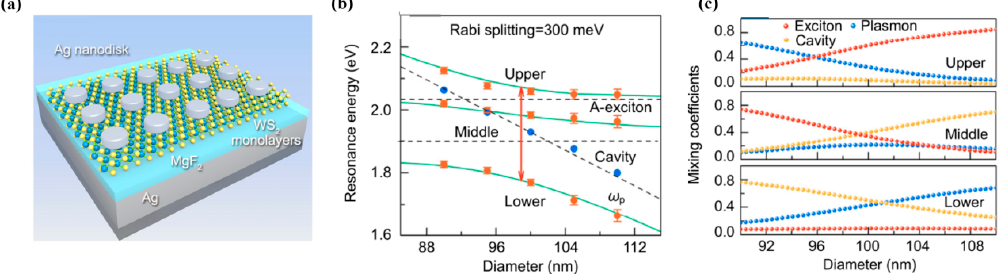
Figure 4. ( a ) Schematic of the Ag–WS 2 heterostructure, where Ag nanodisks were fabricated on WS 2 monolayers by EBL. ( b ) Energies of reflectivity dips as a function of the nanodisk diameter extracted from the reflectivity spectrum. ( c ) Hopfield coefficients for plasmon, exciton, and microcavity contributions to upper, middle, and lower hybrid states as a function of diameter, calculated using the three-coupled oscillator model. Adapted with permission from Ref. [116]. Copyright 2019 Institute of Optics and Electronics, Chinese Academy of